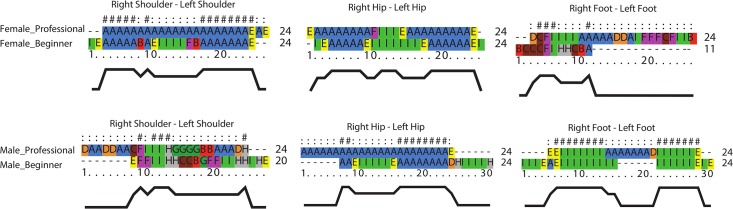
Pairwise alignment of QTCB movement sequences for tango dancers.